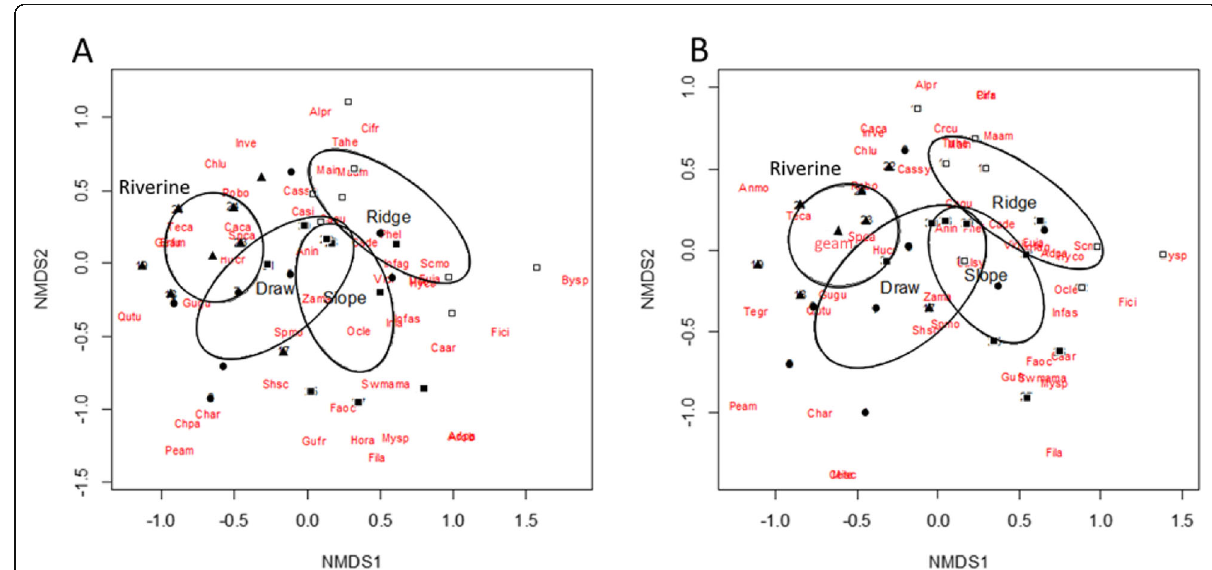
Fig. 4. NMDS ordinations of the forest tree biodiversity in 1997 (A) and 2005 (B) with factor fit of landform type showing species centroids. Riverine sites = triangles, draw sites = circles, slope sites = closed squares, ridge sites = open squares. Species codes are defined in Appendix